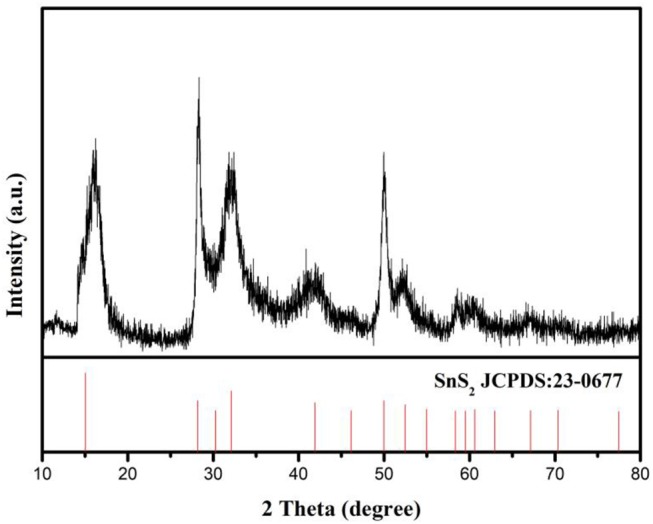
XRD pattern of SnS2/rGO composite.